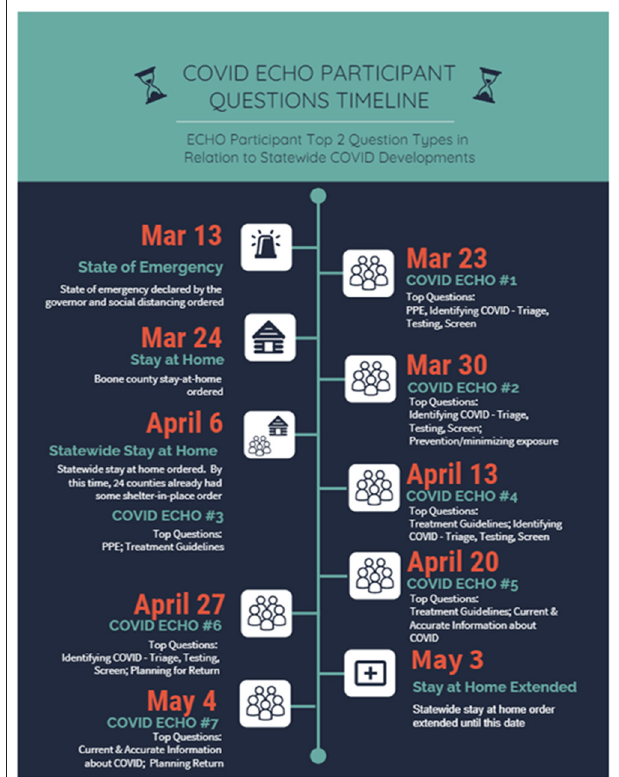
FIGURE 1 | Question